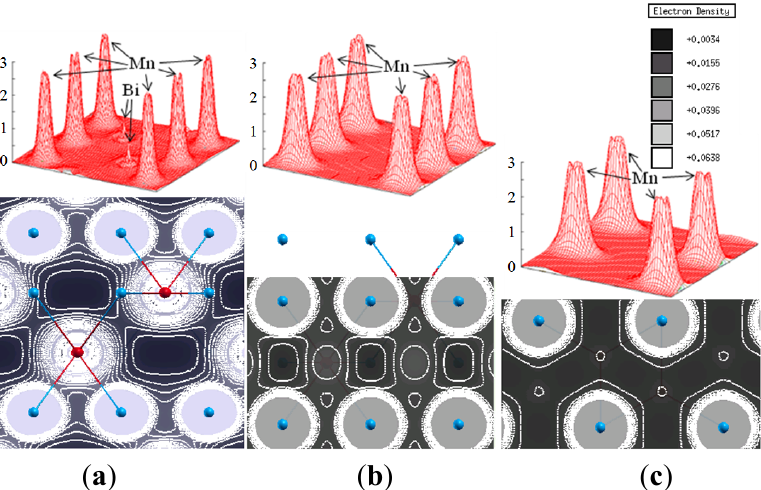
Figure 6. The 3D and 2D electron density maps for LTP MnBi in ( a ) (110), ( b ) (100) and ( c ) (001) planes. The peaks colors, and contour lines indicate the electron density.